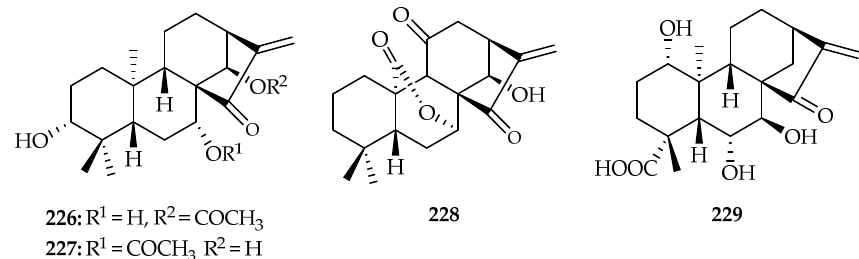
Figure 89. Structure of compound 226 , 227 [140], Jaridon 6 228 [141], and pteisolic acid G 229 [142].